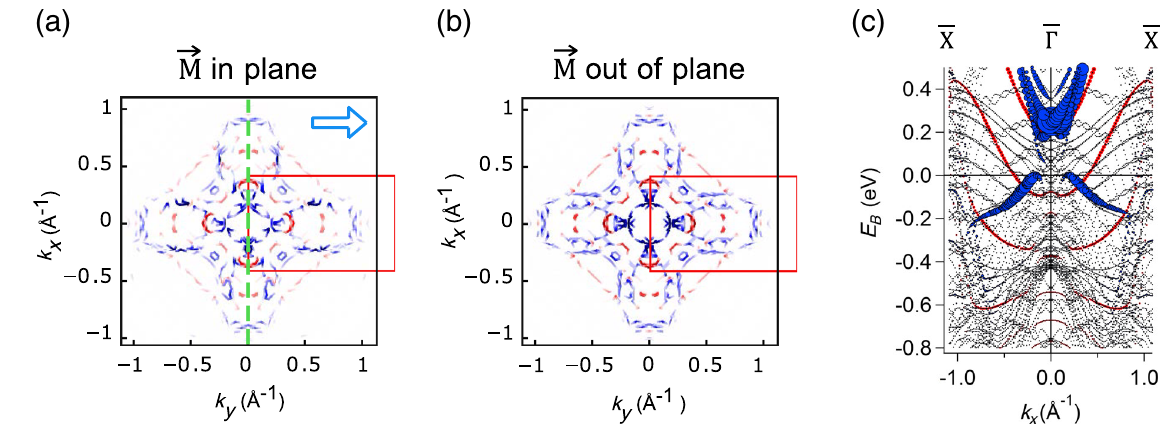
FIG. 4. Results of the relativistic GGA slab calculations that reveal the surface electronic structure of Fe(001). (a) Magnetization in plane. The dashed vertical line marks the mirror plane. (b) Magnetization out of plane. The red rectangles show the fraction of the k space measured in the experiment [Fig. 3(b)]. (c) Dispersions along the localization above the surface layer. Magnetization lies in plane, along the k y axis. Blue (red) symbols correspond to the predominantly minority (majority)